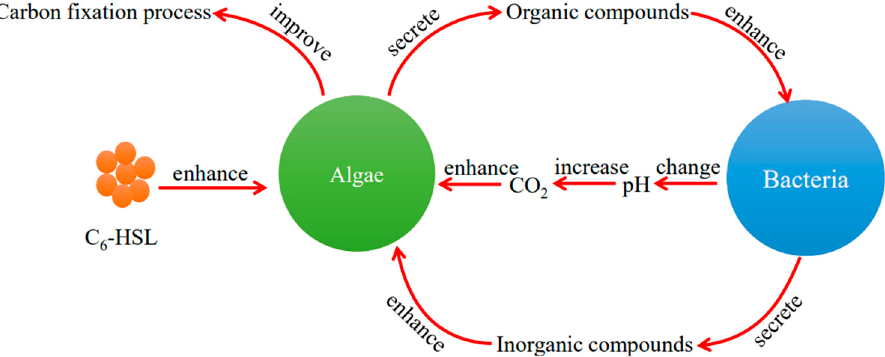
Figure 10. The mechanism of the effect of C 6 -HSL on the algae–bacteria system.